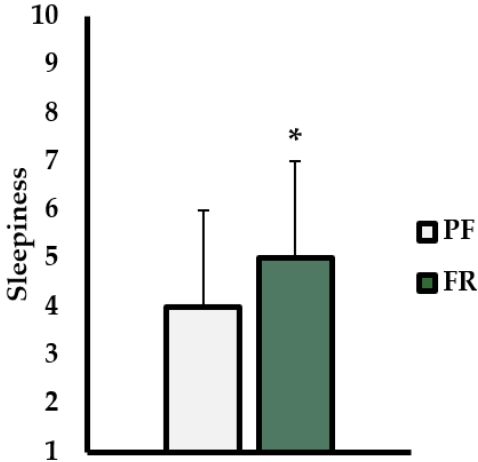
Figure 2. Sleep alertness values (Karolinska sleep scale). 1-Extremely alert; 2-Very alert; 3-Alert; 4-Rather alert; 5-Neither alert nor sleepy; 6-Some signs of sleepiness; 7-Sleepy, but no effort to keep